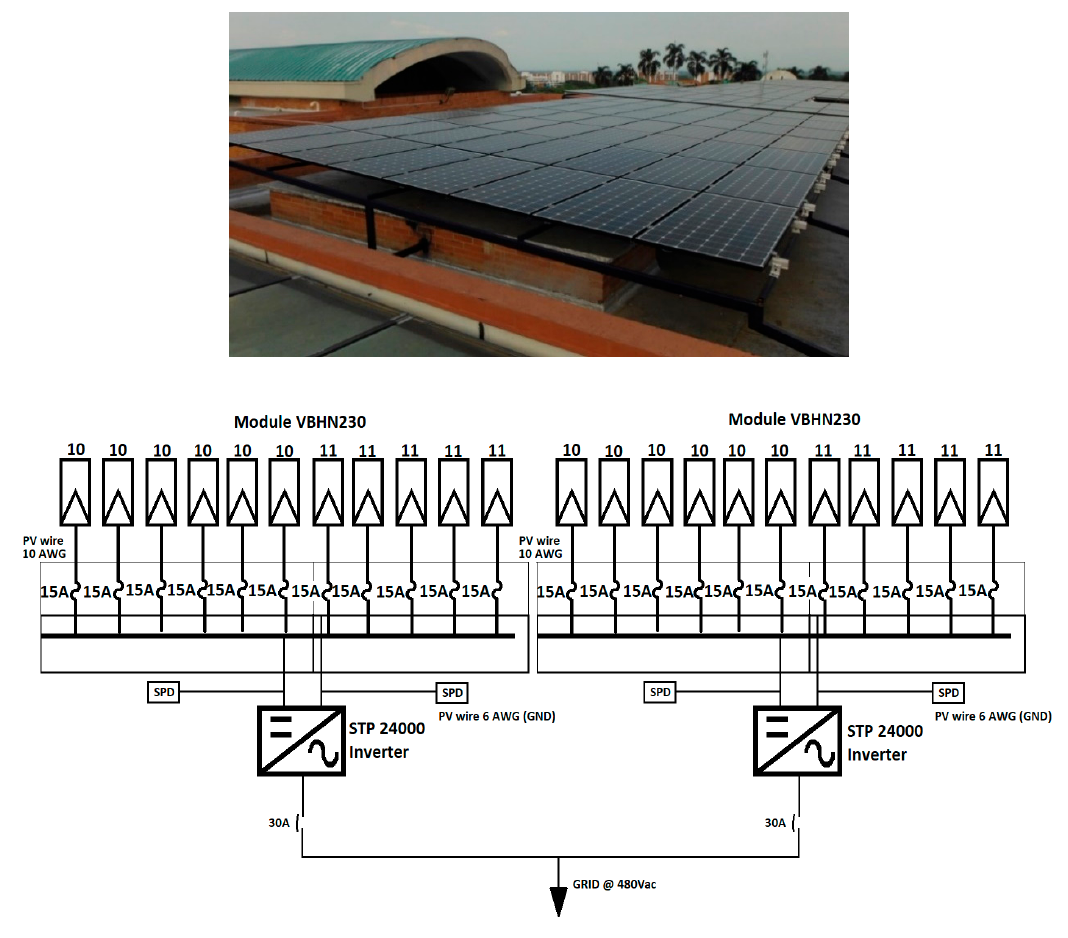
Figure 4. Administration building, South. Stage 1.